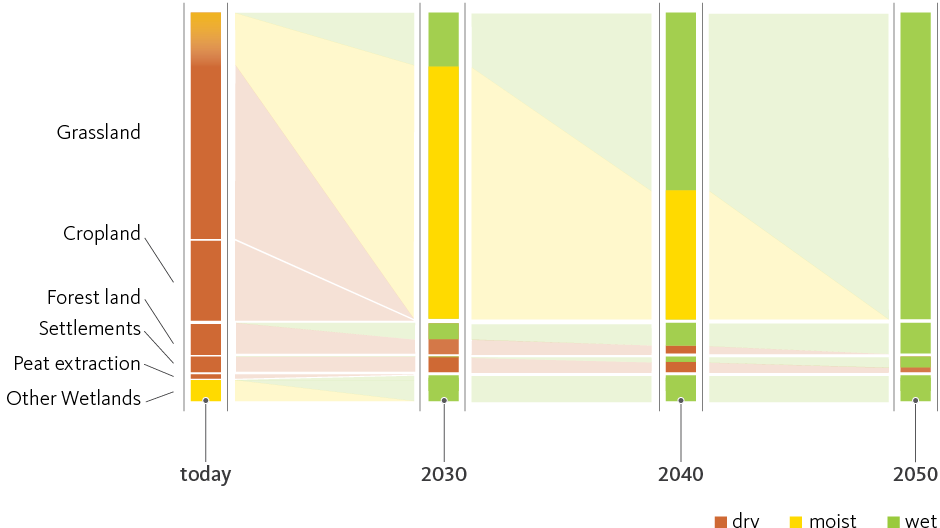
Figure 1. Net zero CO 2 emission pathway for organic soils in Germany visualising transformation by land use category (in % of total area of organic soils) over the period 2020–2050 (pathway 1). Dry=deep-drained, moist=shallow-drained (mean annual water table ~30 cm below soil surface), wet=undrained/rewetted (mean annual water table at the soil surface).